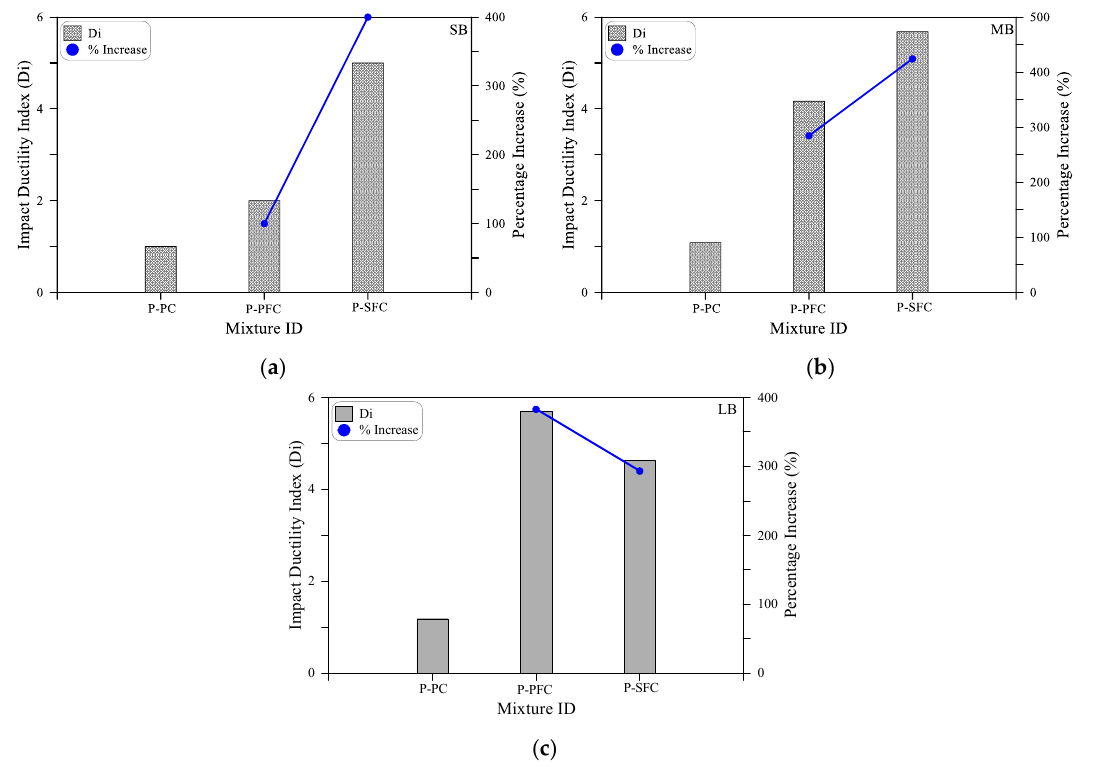
Figure 14. Impact ductility index (Di) of the three mixtures: ( a ) SB; ( b ) MB; ( c ) LB.